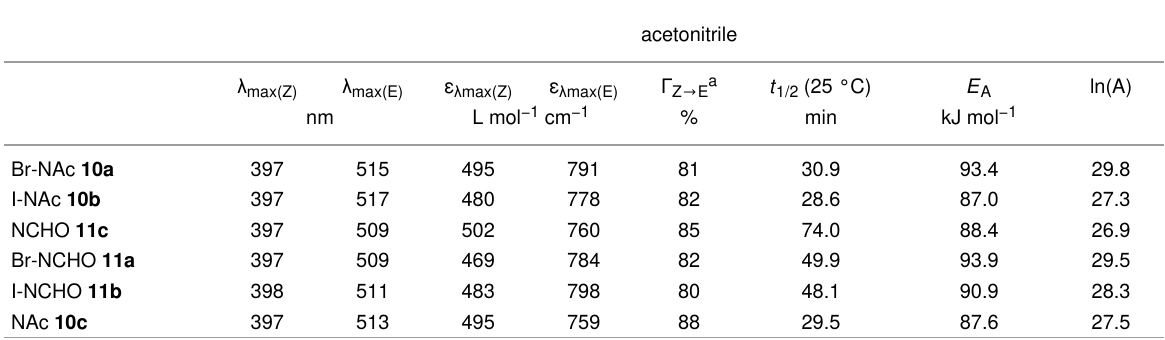
Table 1: Photophysical properties of N -diazocines 10a – c and 11a – c in